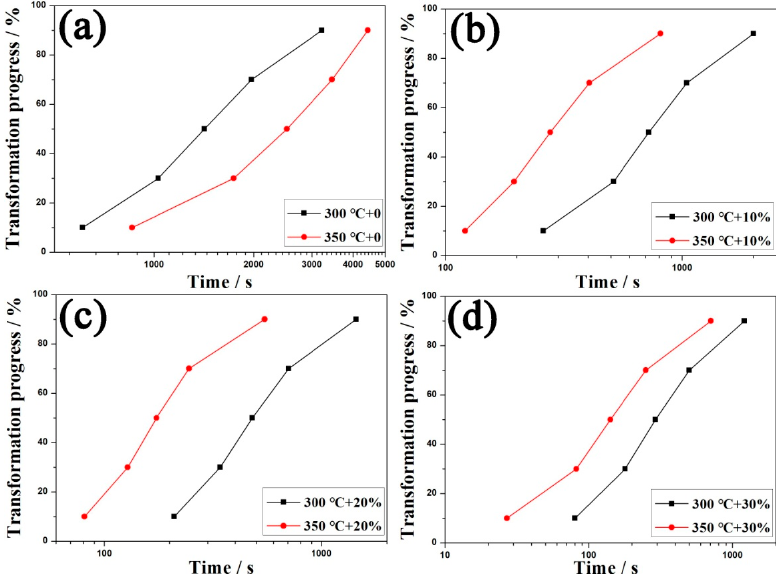
Figure 6. Bainite transformation kinetics in different samples measured using dilatometry: ( a ) nondeformed samples; deformed with a strain of ( b ) 0.1; ( c ) 0.2; ( d ) 0.3.